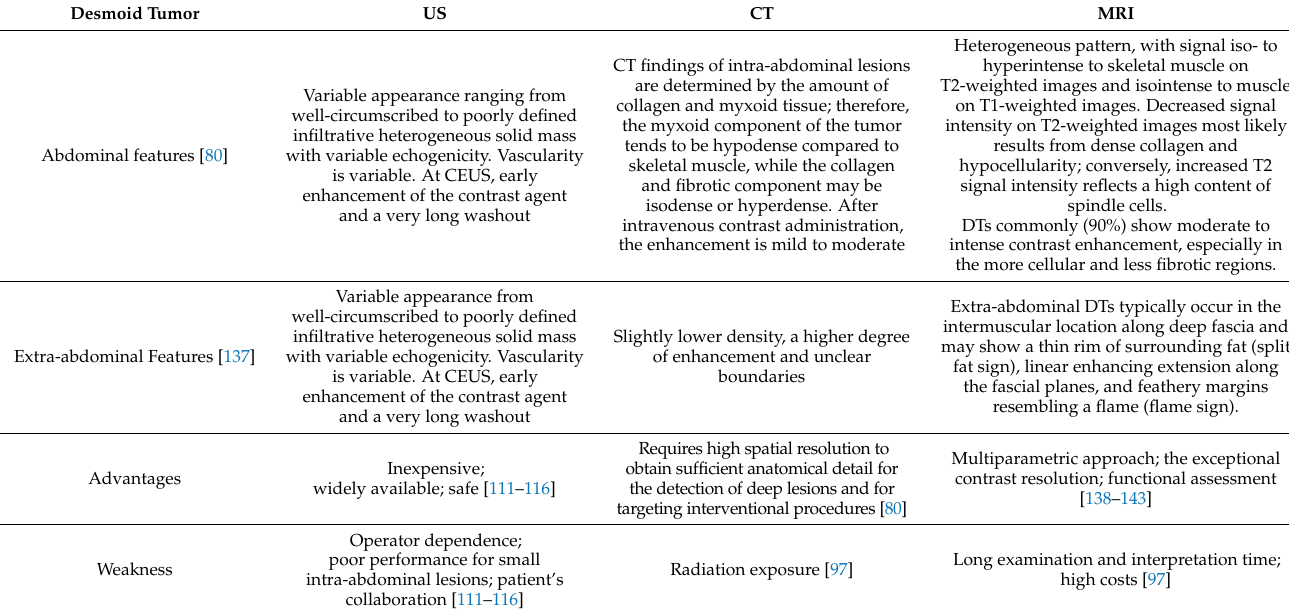
Table 1. Imaging features of abdominal and extra-abdominal DTs and advantages and weaknesses of diagnostic